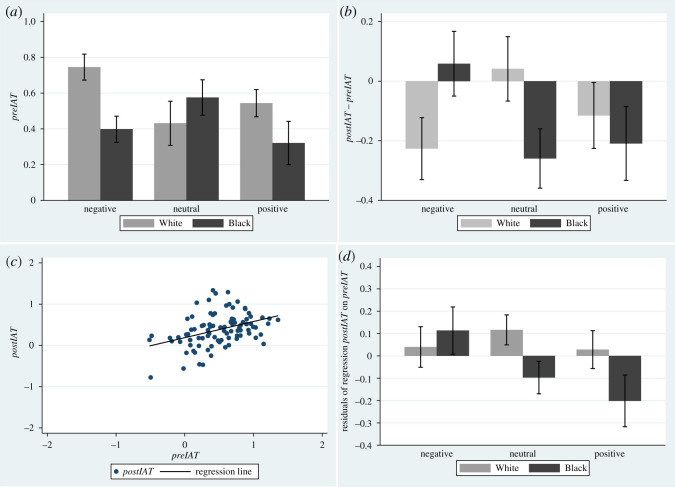
Implicit bias as measured by the IAT. (a) Bar chart showing means and standard errors for preIAT. (b) Bar chart for postIAT – preIAT. (c) Scatter diagram of postIAT on preIAT. (d) Bar chart of the residual errors of the regression of postIAT on preIAT.